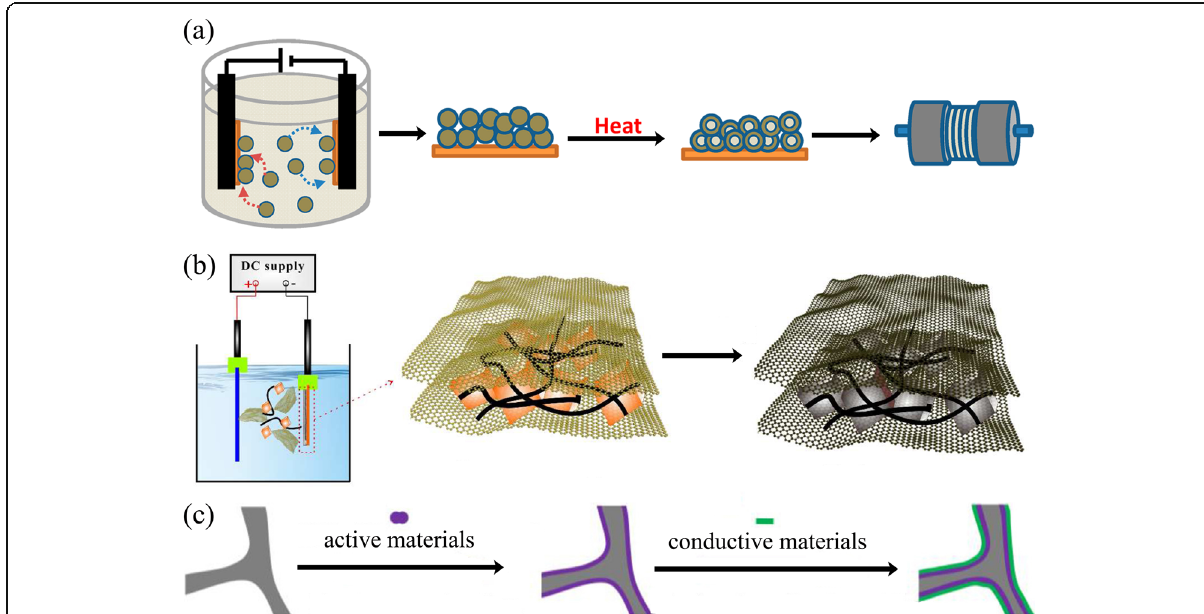
Fig. 6 a Schematic of process for fabrication of binder-free, carbon-free film electrodes [101]. b Schematic fabrication process for the Fe 3 O 4 /CNTs/ rGO composite electrode [102]. c Schematic illustration of the synthesis route for rGO/active materials/Ni foam